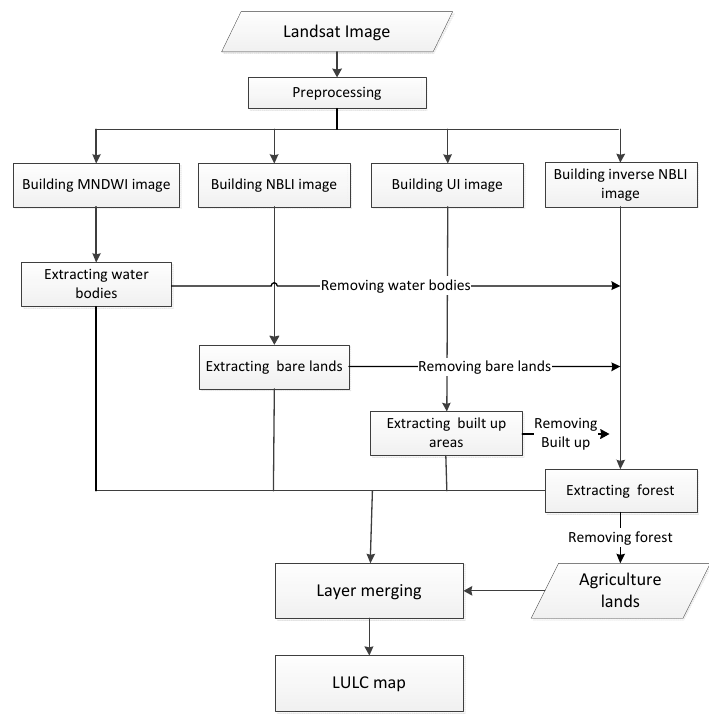
Figure 3. The flowchart of the unsupervised classification method.